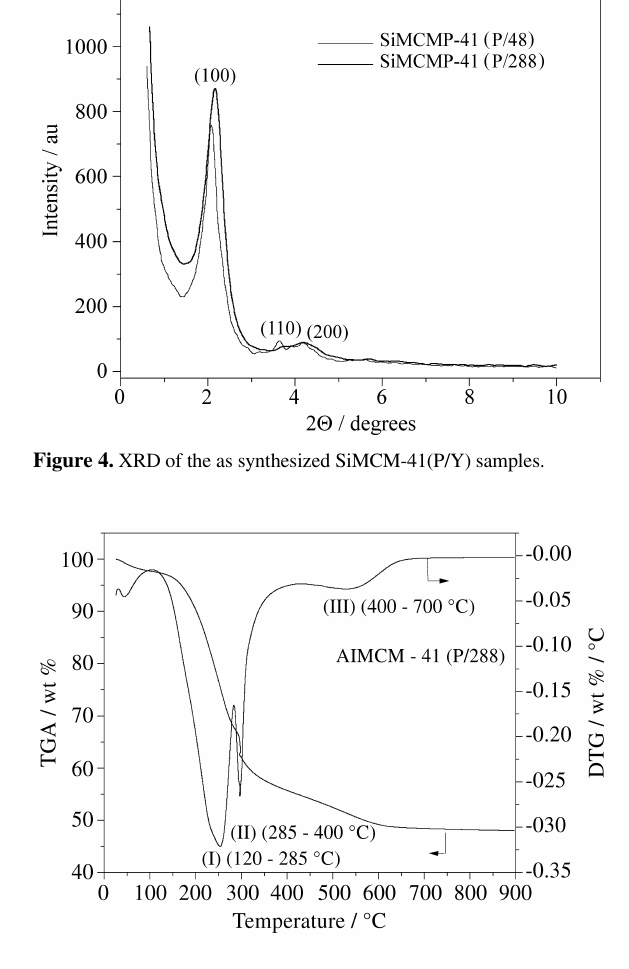
Figure 5. TGA-DTG analysis of the as synthesized AlSiMCM-41 (P/288) sample.